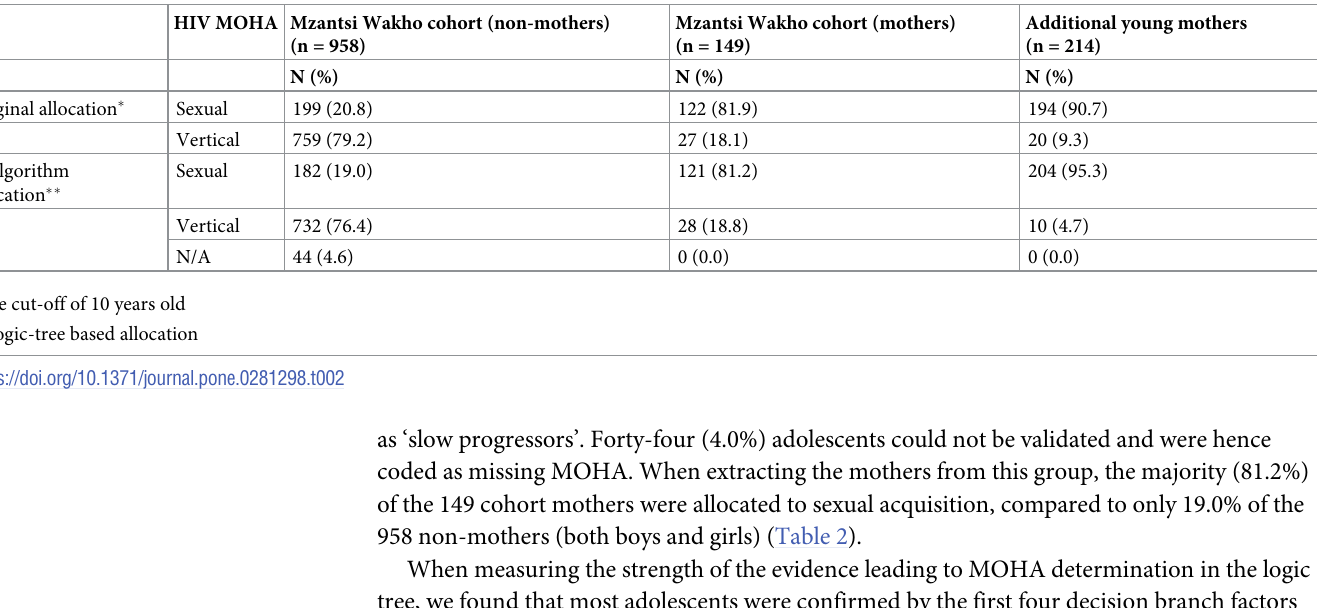
Table 2. Original HIV mode of acquisition allocation based on an age cut-off of 10 years and an adjusted allocation incorporating the logic tree decision-making algorithm for the adolescent cohort (non-mothers), adolescent cohort (mothers) and additional mothers.